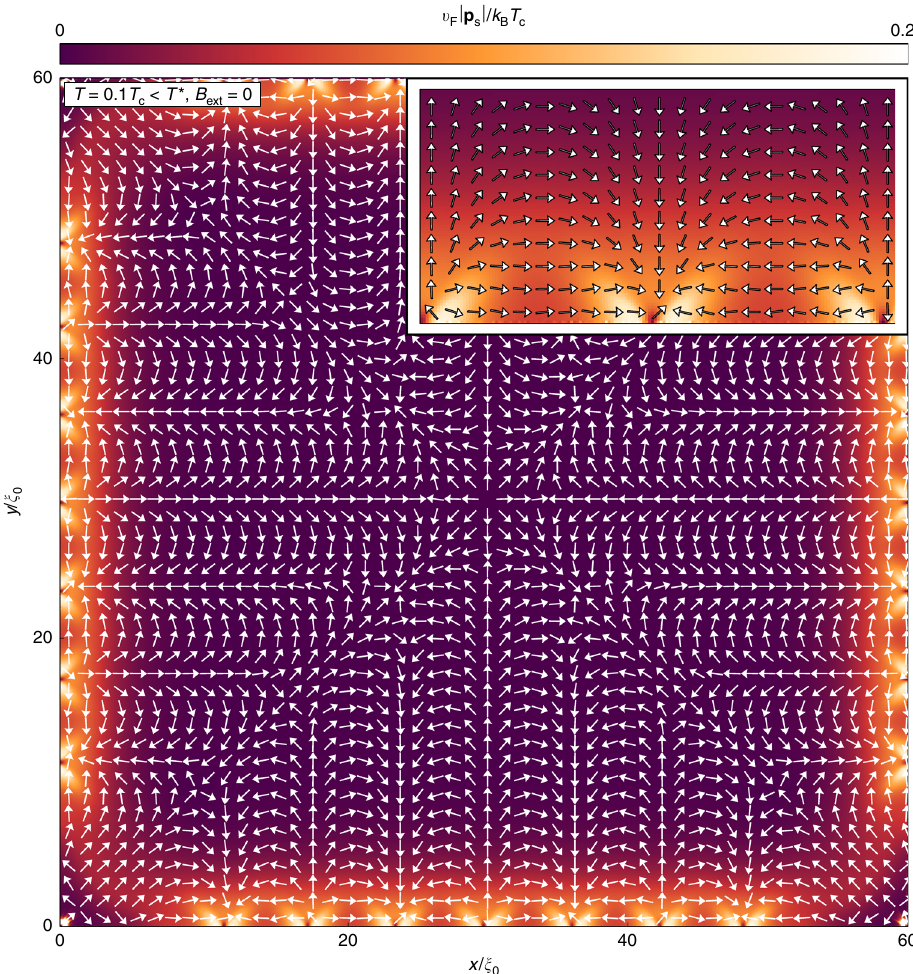
Fig. 1 Super fl uid momentum as a vector fi eld. The super fl uid momentum p s forms a non-trivial planar vector fi eld with a regular chain of sources and sinks along the edge, thereby breaking local continuous translational symmetry along the edge. Several critical points, including saddle points, sources, and sinks, are formed in the interior. The Poincaré indices of the critical points add up to ful fi ll the generalized Poincaré-Hopf theorem in Eq. (3). The magnetic fi eld is zero, B ext = 0, while the temperature is T = 0.1 T c . Since T is well below T * , the splay patterns are rather stiff, leading to triangular shapes near the edges. The stiffness is clear from the magnitude variation shown in color scale. The inset shows one period of the edge